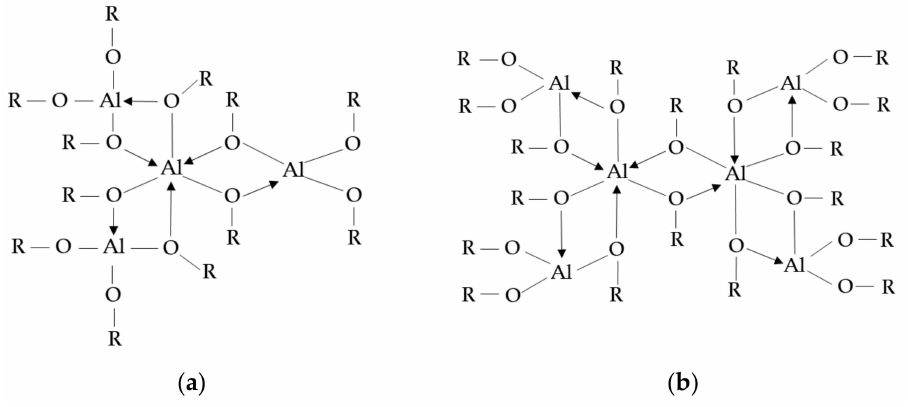
Figure 2. Tetrameric ( a ) and hexameric ( b ) structures of aluminum